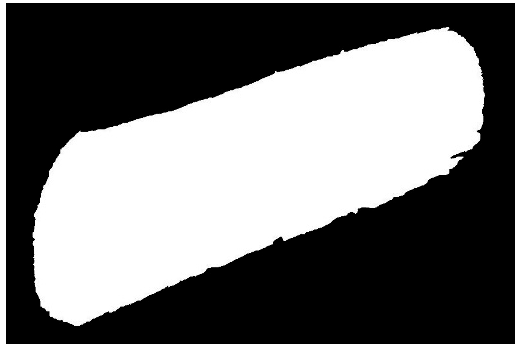
Figure 9. Standard segmented image.